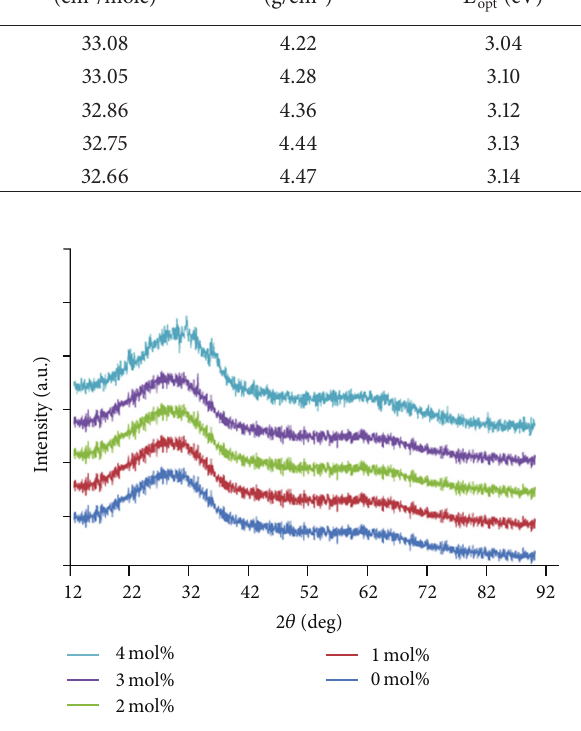
Figure 2: The XRD pattern of the EZT glasses.